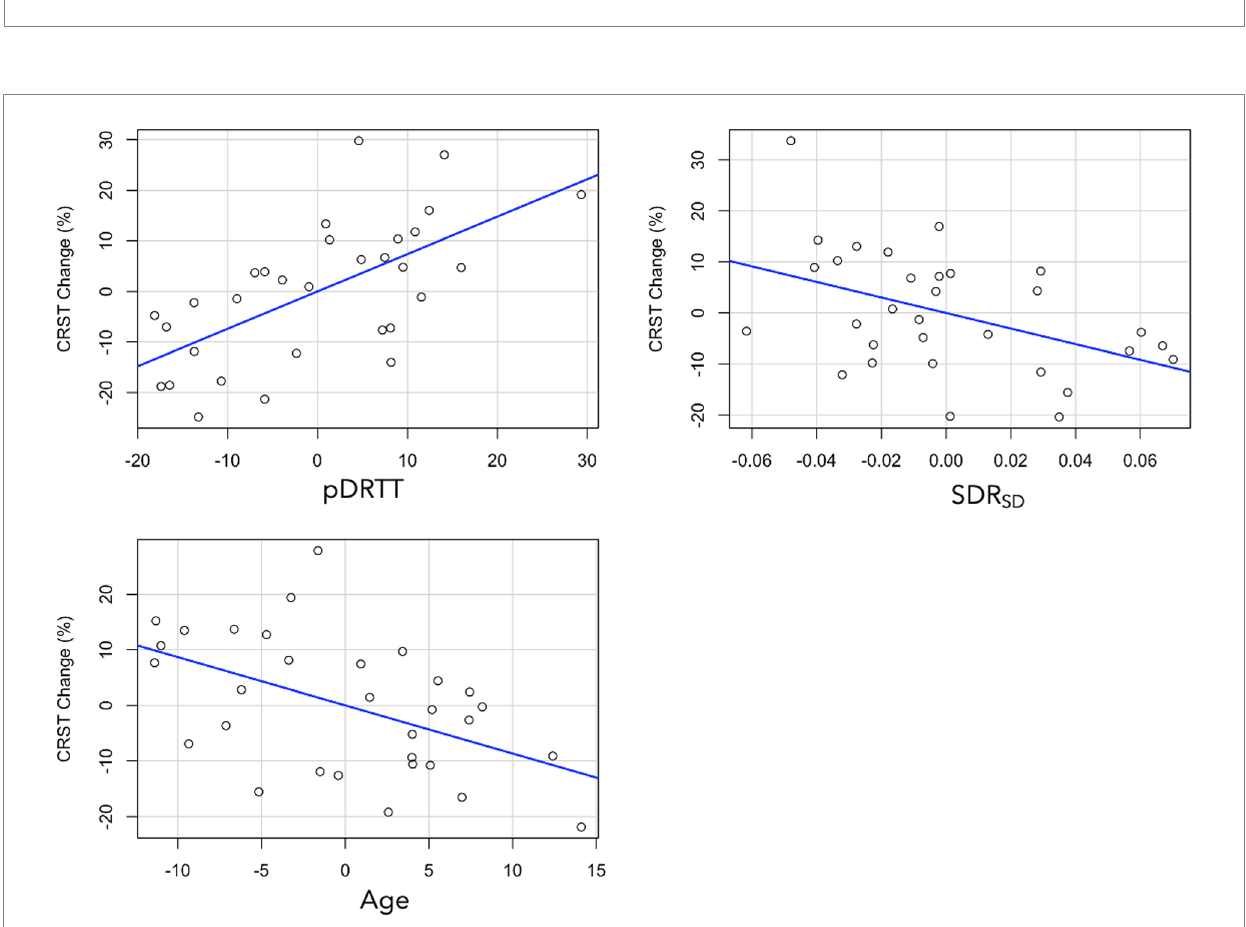
FIGURE 4 Partial plots from multivariate regression with CRST change as dependent variable for pDRTT (top left), SDR SD (top right) and age (bottom left). All variables are mean